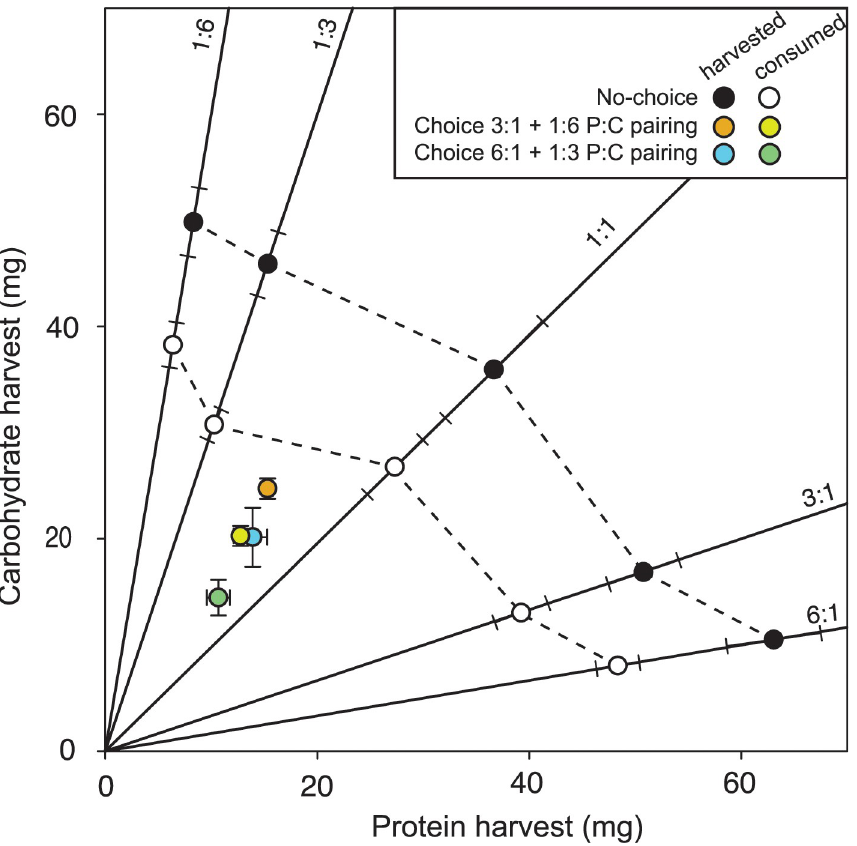
Fig 2. Nutritional geometry in two dimensions. In a choice experiment lasting 12 days, colonies reliably harvested and consumed a slightly carbohydrate-biased 1:1.5 P:C intake target in both choice diet combinations. In a no-choice experiment, colonies exhibited a generalist equal distance intake array (dashed lines) by harvesting similar excesses of protein and carbohydrates relative to their intake target. Diet consumption (subtracting scattered and hoarded amounts from harvested diet) tightly matched diet harvest. Solid black lines show nutrient rails for each no-choice P:C diet treatment. Choice experiment harvest values are provided with bi-directional error bars, and no-choice harvest values provided with pythagorean standard error bars aligned with the intake rail (as per